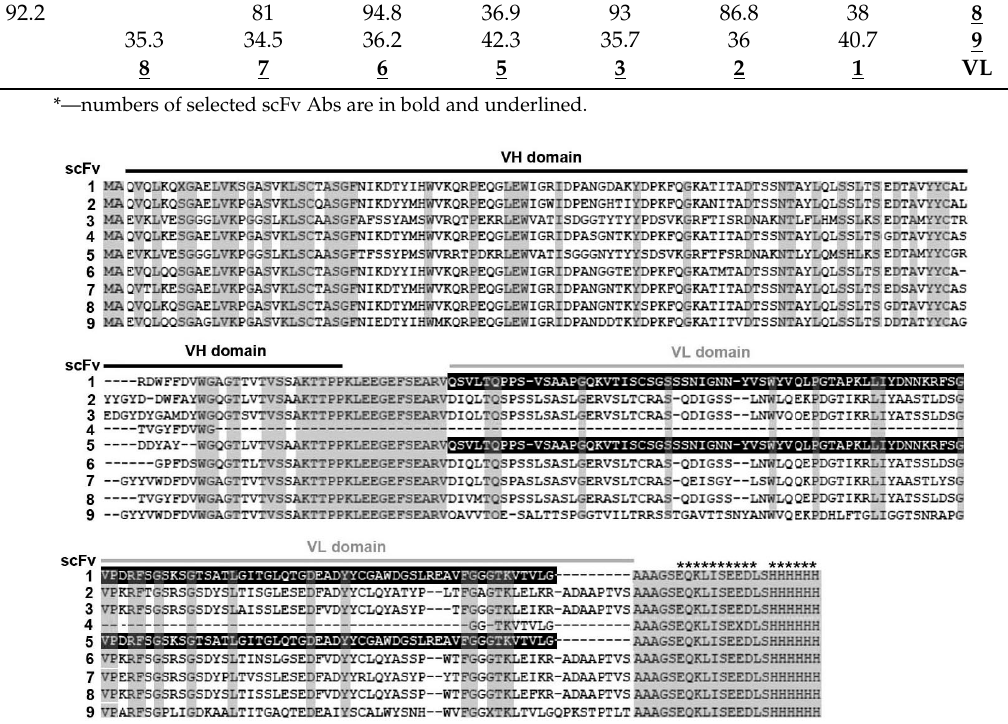
Figure 3. Multiple a/a sequence alignment of nine selected scFv antibodies. VH and VL domains are indicated by black and gray horizontal lines respectively, gray rectangles indicate conserved residues present in all selected scFv fragments, the human VL domain from the pSEX81 phagemid retained in scFv1 and scFv5 is marked in inverted color, recombinant c-Myc and polyHis peptides are marked with